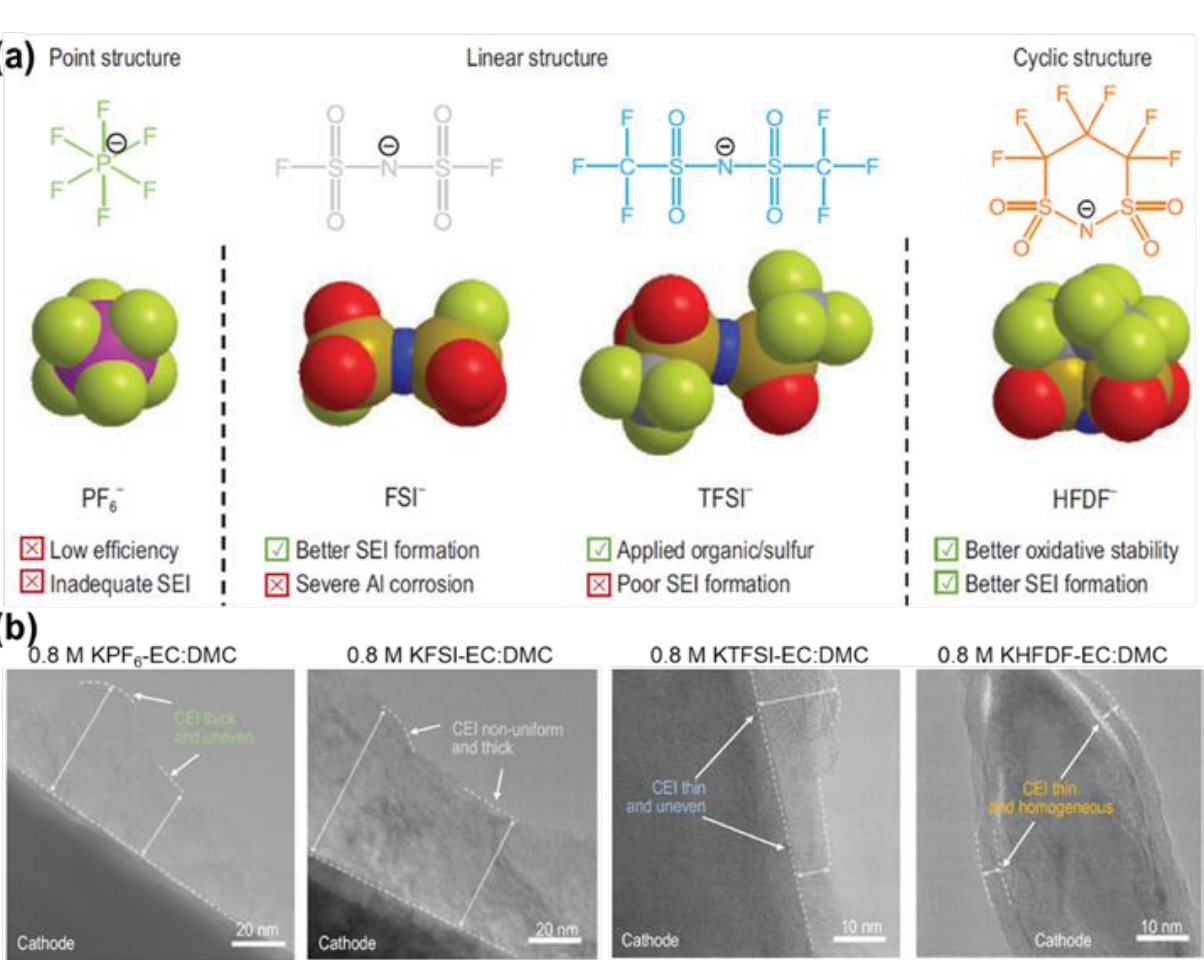
Figure 6. ( a ) Molecular structures and characteristics of PF 6 − , FSI − , TFSI − , and HFDF − anions (Atoms in molecular structures: F−green; P−purple; N−blue; S−brown; O−red; C−grey) . ( b ) Comparison of CEI with KPF 6 − , KFSI − , KTFSI − , and KHFDF − based electrolytes by TEM morphology. Reprinted with permission from Ref. [68]. Copyright 2022, Oxford University Press. Table 3. Solubility (M (mol/L)/m (mol/kg) at 25 °C) of most used potassium salts in typical solvents. Solubility